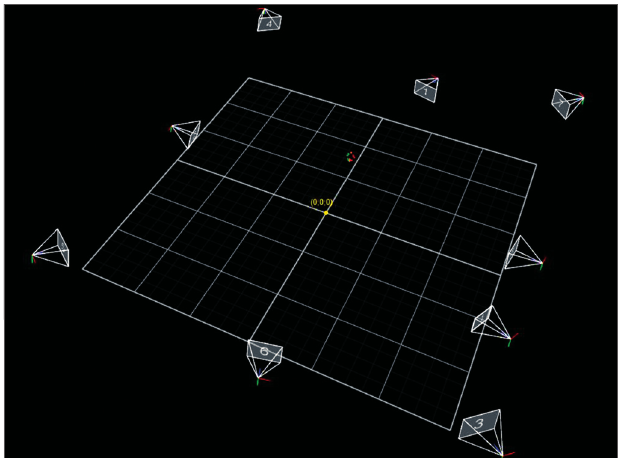
Figura 5. Demonstração da origem (0 0,0).